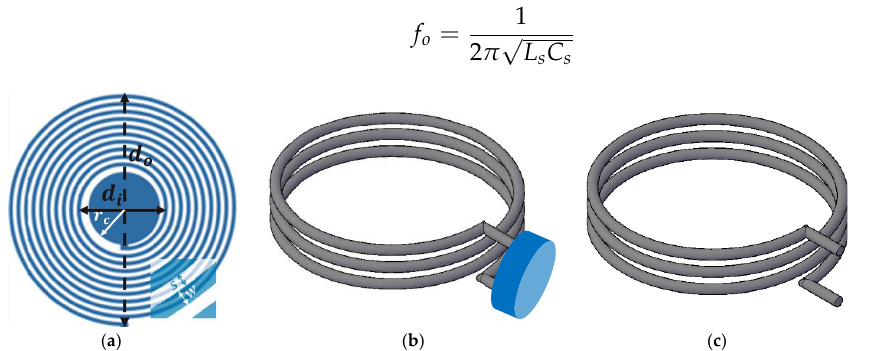
Figure 2. ( a ) A geometrical representation of a circular LC sensor with an outer diameter (𝑑 𝑜 ) , inner diameter (𝑑 𝑖 ) , trace width (𝑤) , trace separation (𝑠), and electrode with radius (𝑟 𝑐 ) . ( b ) Repeater coil connected with a fixed value capacitor (shown in blue). ( c ) Reader coil with terminals opened for VNA connection.